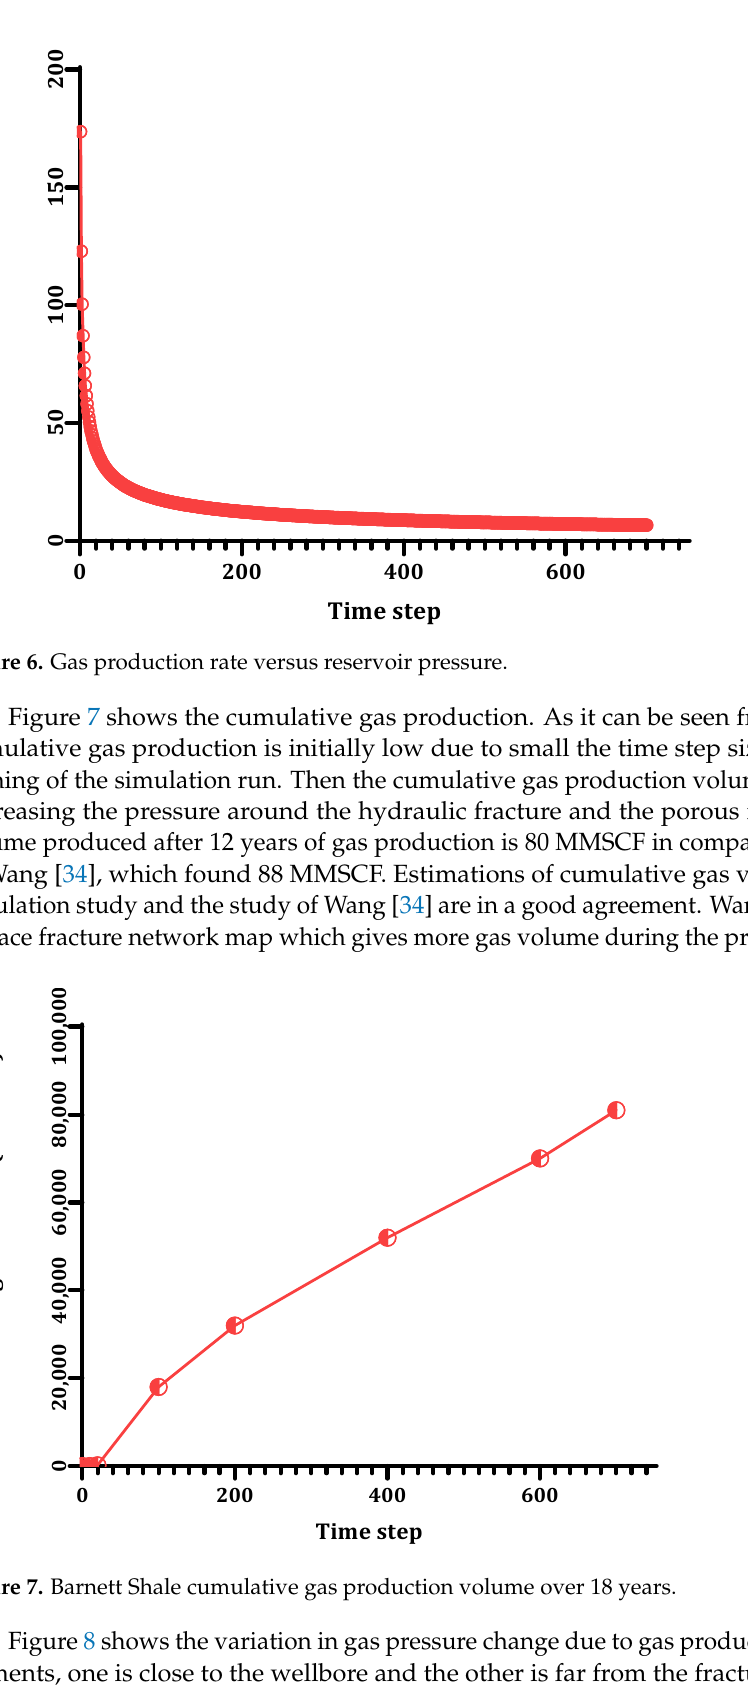
Free Adsorbed Figure 5. Free gas and adsorbed gas content for Barnett Shale versus reservoir pressure. Using the permeability of 0.001 md as homogenous reservoir property, the gas pro- duction profile is obtained, as shown in Figure 6. The gas production profile shows a long term well performance of 18 years, and this performance is required during the produc- tion process in shale gas reservoirs. The gas well is produced at constant bottom hole pressure of 2550 psi at the initial production stage. The free gas exists in the natural frac- ture and pores. The gas is produced continuously from the fracture until the pressure in the matrix reaches the critical desorption pressure. Then, the adsorbed gas feeds the po- rous area through the desorption process at a rate depending on the pressure change.